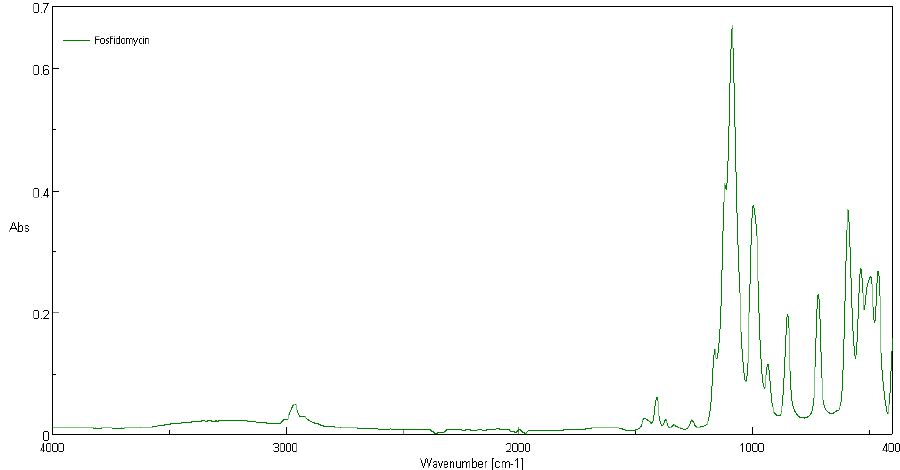
Figure 4. ATR-FTIR spectrum of fosfonomycin.